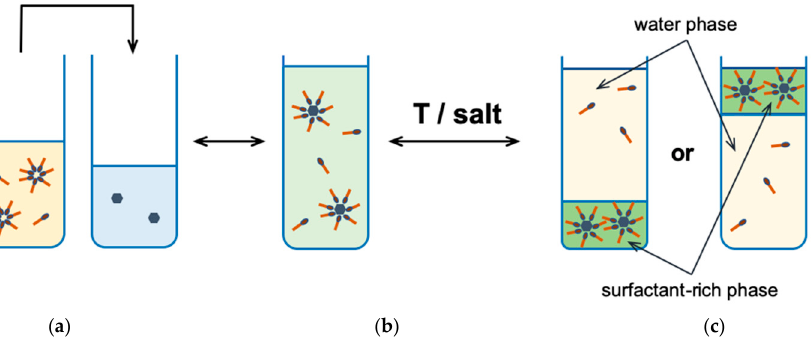
Figure 4. The cloud point extraction: ( a ) an analyte solution; ( b ) an analyte solubilized in micelles after adding surfactant solution; ( c ) a phase separation after temperature change or by adding salt [40].